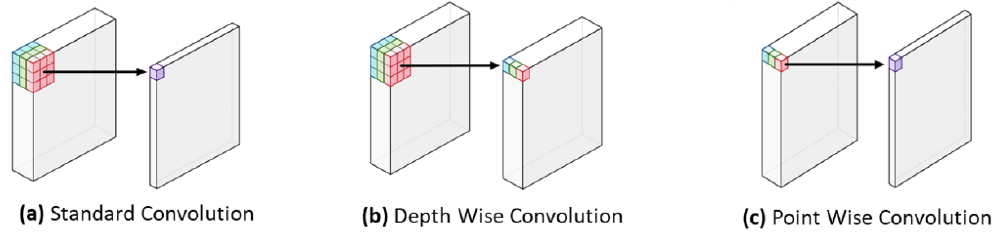
Figure 3. Visualization of different kinds convolution operations: ( a ) standard convolution; ( b ) depth-wise convolution; ( c ) point-wise convolution.